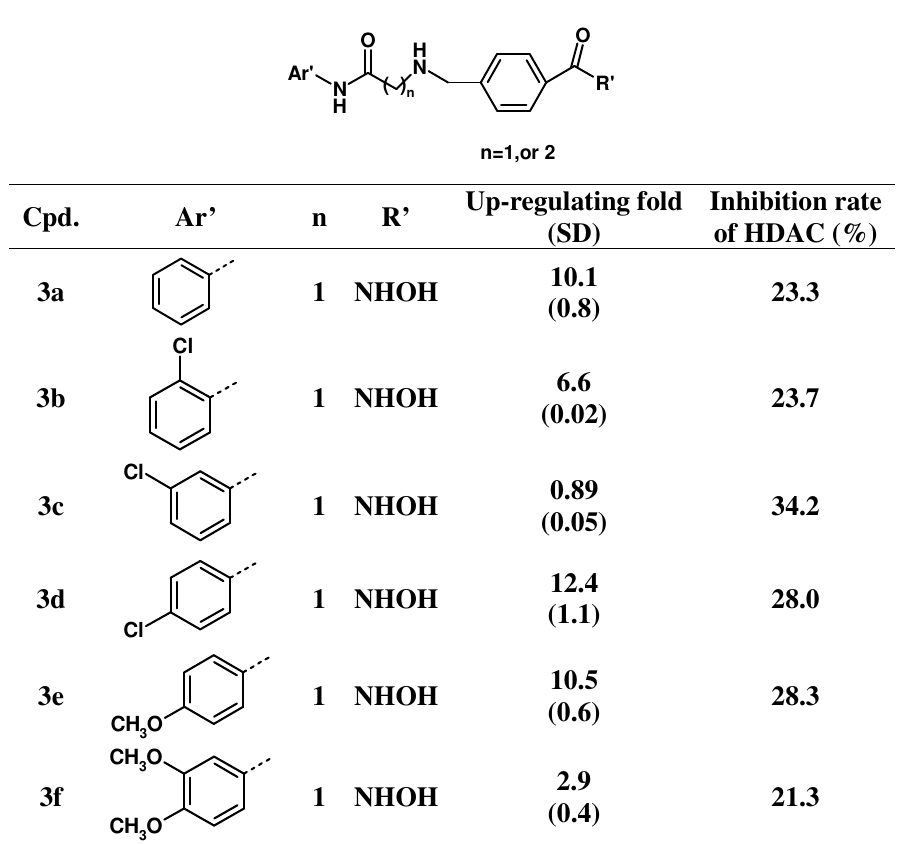
Table 3. Up-regulating activities of CLA-1 expression in HepG2 cells and inhibition rate of HDAC of compounds 3a-o , 12a-d